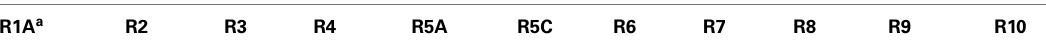
Table 2 | Summary of RASSF promoter methylation